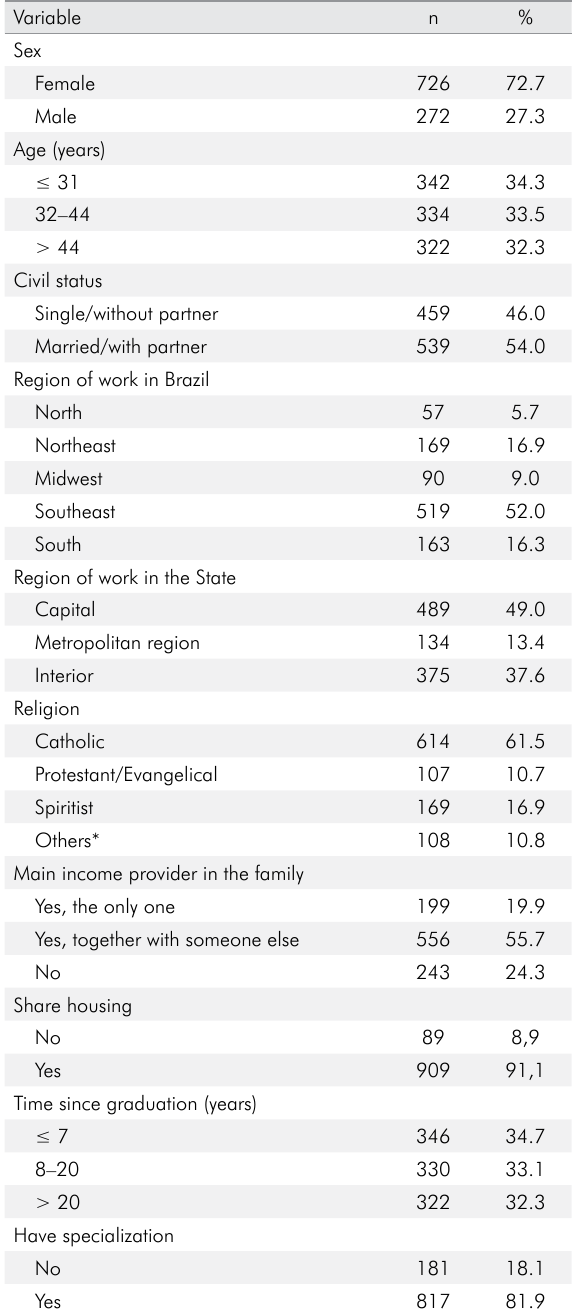
Table 2. Distribution of study participants according to factors related to the COVID-19